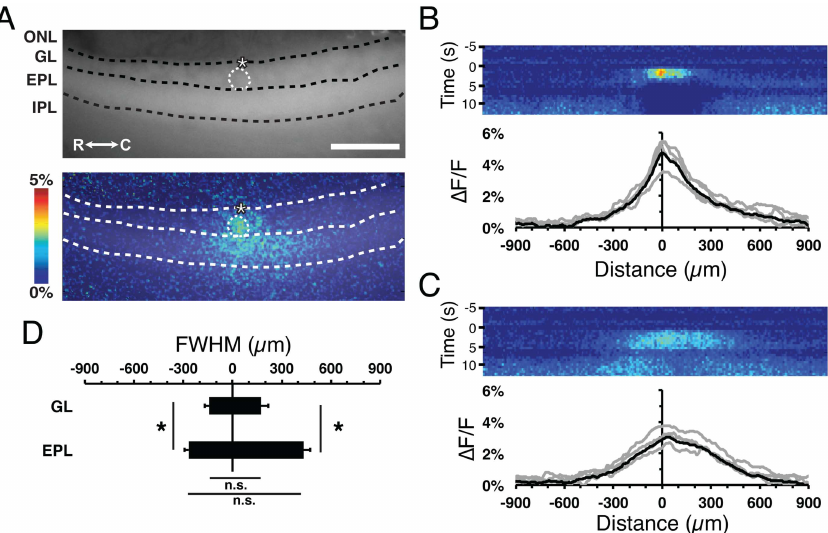
Fig 8. Intrinsic NAD(P)H signal response in olfactory bulb upon electrical stimulation of canonical glomerulus. (A) (left) Resting light fluorescence image of a horizontalMOB slice under 4x magnification. ONL, olfactory nerve layer; GL, glomerular layer; EPL, external plexiform layer; MCL, mitral cell layer; IPL, internalplexiformlayer; GrL, granulecell layer; R, rostral; C, caudal.Asterisk, tip of the stimulatingelectrode. Targeted glomerulusindicatedby dashedcircle. Scale bar = 150 μ m (right) Representative overlaidpseudo-colored Δ F/F images indicating the signal spread followinginitiationof train stimulation at 0s. (B) (left) Resting light fluorescent image of the demarcated regionof the same slice in A at 10x magnification. Asterisk, tip of the stimulatingelectrode. Targeted glomerulusindicatedby dashed circle. (right) Representative overlaid,pseudo-colored Δ F/F frames followinginitiationof train stimulation at 0s. Scale bar = 400 μ m.